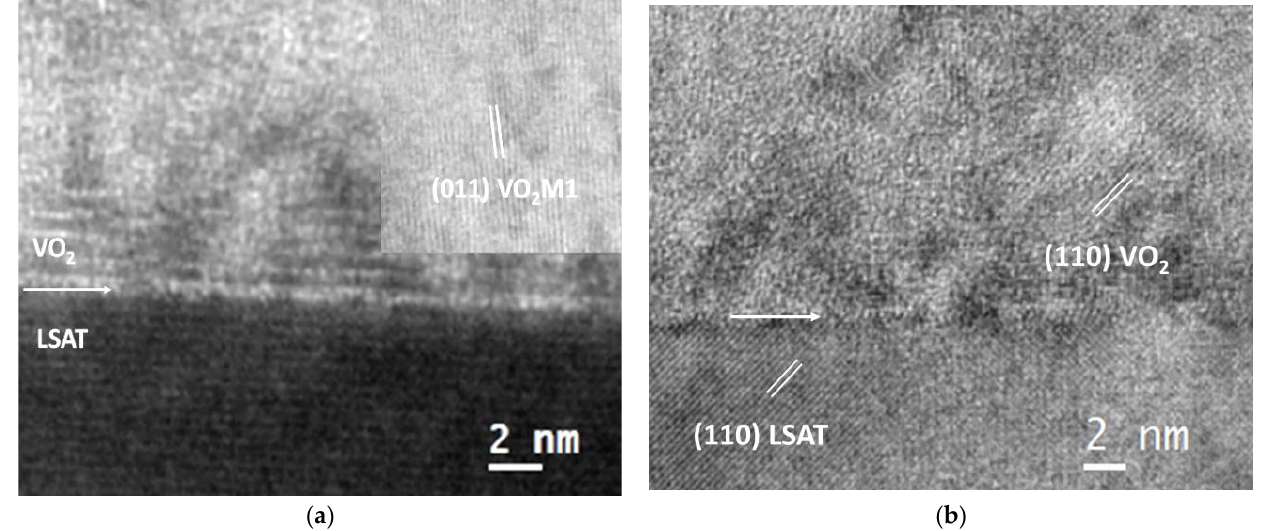
Figure 2. HRTEM images from the VO 2 /LSAT interface showing the interfacial quality and the dominant VO 2 M1 phase.